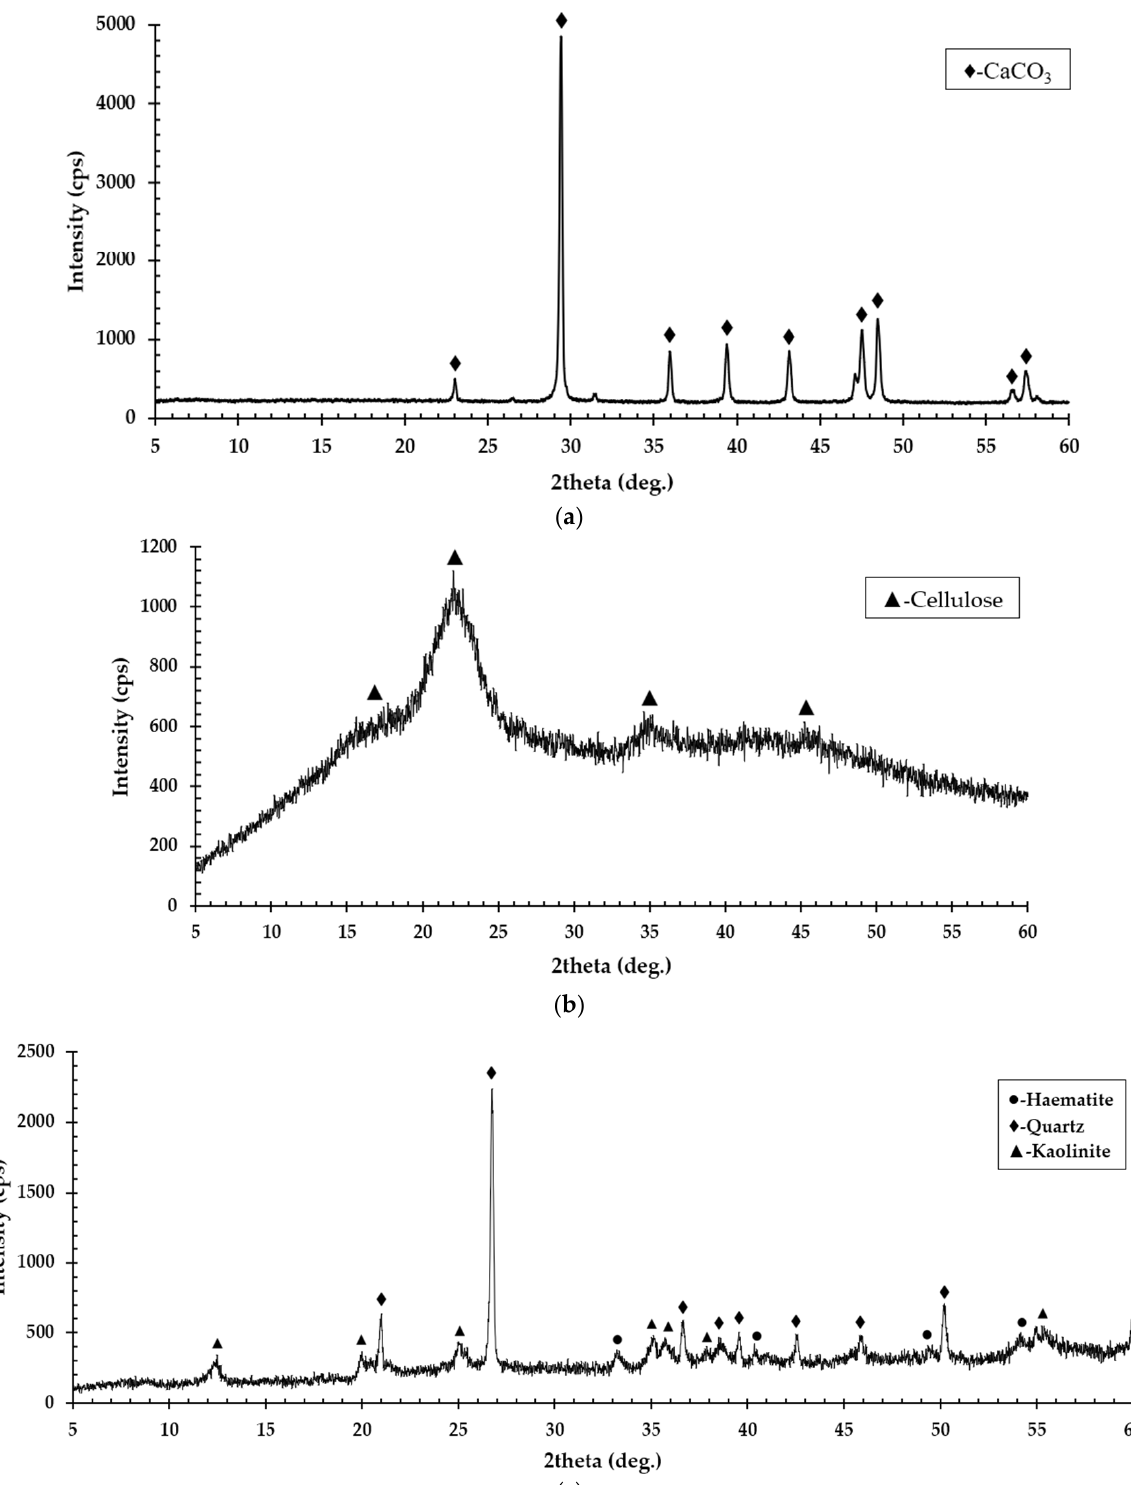
Figure 5. XRD spectrograms of raw materials: ( a ) EP; ( b ) WSG; ( c ) RCP.